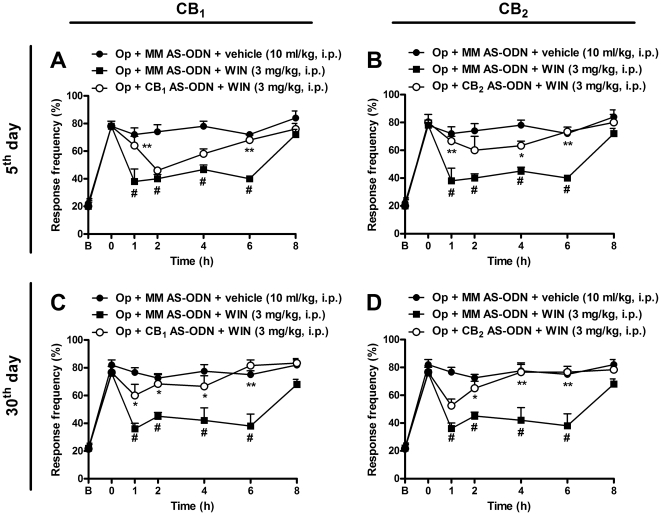
Effect of treatment with antisense oligodeoxinucleotide (AS-ODN) against the CB1 or CB2 receptor on mechanical allodynia induced by brachial plexus avulsion (BPA) in mice.Different groups of operated (Op) mice received an i.t. injection twice daily of mismatch AS-ODN (12.5 µg/site), CB1 AS-ODN (12.5 µg/site) or CB2 AS-ODN (12.5 µg/site). Systemic administration of WIN 55,212-2 (3 mg/kg, i.p.) produced a significant reduction of mechanical allodynia induced by BPA on the 5th (A and B) and 30th (C and D) days after surgery. The antinociceptive activity of WIN 55,212-2 (3 mg/kg, i.p.) was inhibited by both CB1 AS-ODN (12.5 µg/site, i.t.) and CB2 AS-ODN (12.5 µg/site, i.t.) on the 5th (A and C) and 30th (B and D) days after surgery, respectively. AS-ODN were administered on three consecutive days starting on the 2nd and 27th days after BPA surgery. The mice which received mismatch (MM) AS-ODN demonstrated similar responses throughout the testing period. Data are expressed as mean ± SEM (n = 4–6/group). *p<0.05 and **p<0.01, significantly different from the operated group that received MM AS-ODN and treated with WIN 55,212-2 (two-way ANOVA with Bonferroni's post hoc test). #p<0.01, significantly different from operated-mice group (Op) that received MM AS-ODN and treated with vehicle. B, Baseline withdrawal threshold before surgery. 0, baseline withdrawal threshold after surgery on the day of the experiment (5th and 30th days).